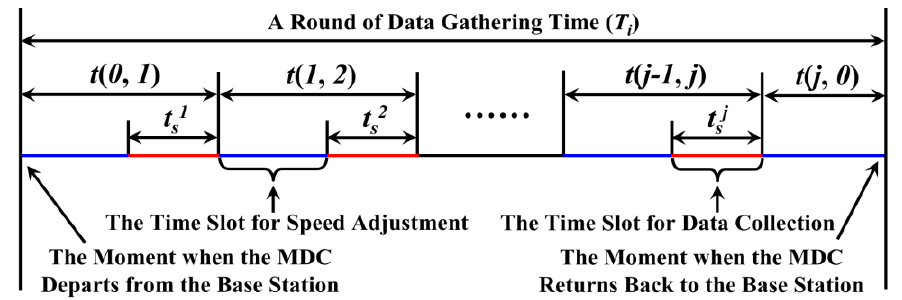
Figure 15. The sequence diagram about data collection and speed adjustment in T i .